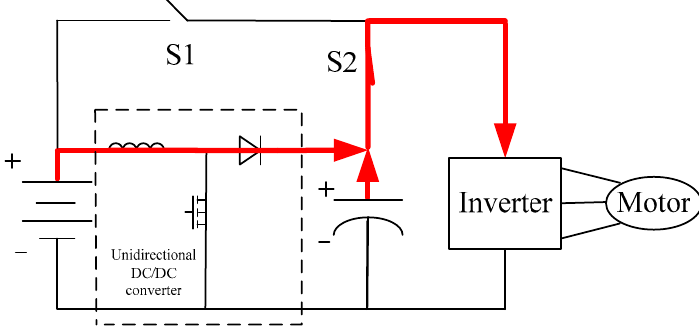
Figure 5. Mode 2—both the battery and supercapacitor discharge.